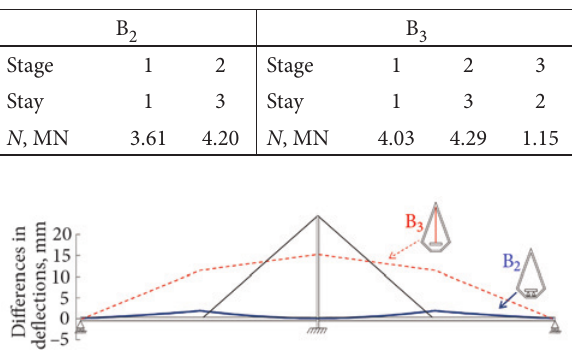
fig. 1. Academic examples : a − B 3 ; b − B 2 ; c − girder on temporary supports. Stays are named S 1 , S 2 and S 3 Note that bridge B 2 has only two stays named S 1 and S 3 , m table 2. Tensioning operations in B 2 and B 3